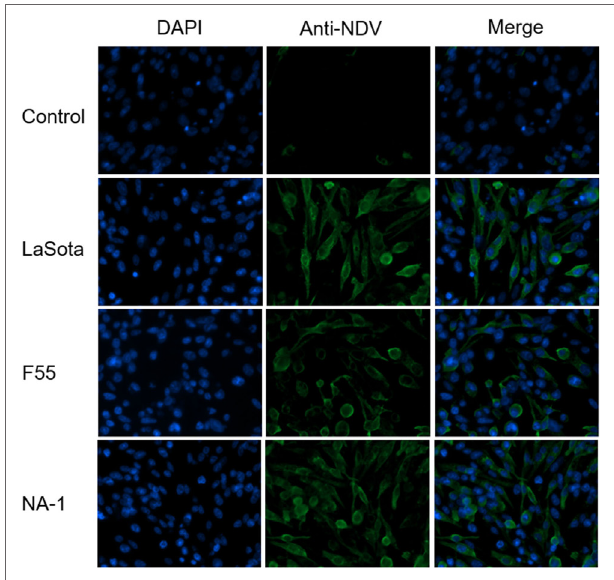
FigUre 1 | Characteristics and infection efficiency of three different virulence and genotypes Newcastle disease virus strains in chicken macrophages analysis by immunofluorescence. HD11 cells were infected with three different virulence and genotypes NDV strains (including virulent class II genotype VII strain NA-1, lentogenic class II strain genotype III strain LaSota, and lentogenic class I genotype I strain F55) at a MOI of 2 for 24 h, then viral infection efficiency was determined by immunofluorescence. Primary Mouse anti-NDV polyclonal antibody for NDV and secondary Goat Anti-Mouse IgG H&L (Alexa Fluor ® 488) antibody were used for immunofluorescence, and 4 ′ ,6-diamidino-2-phenylindole was used for labeling DNA to define the nuclear